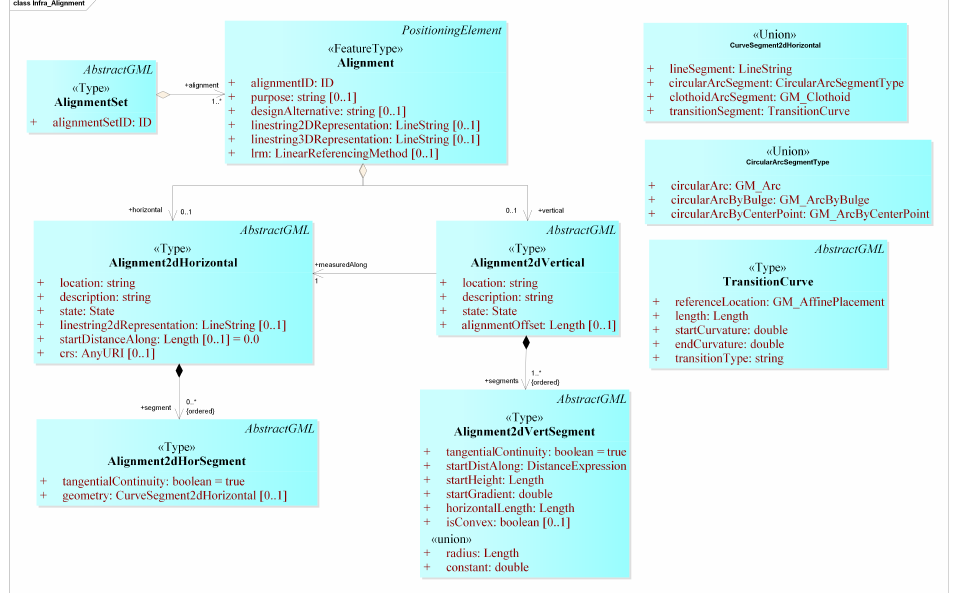
Figure 5. The UML excerpt depicts the Infra_Alignment introduced in the Infra ADE for linear referencing of the features.